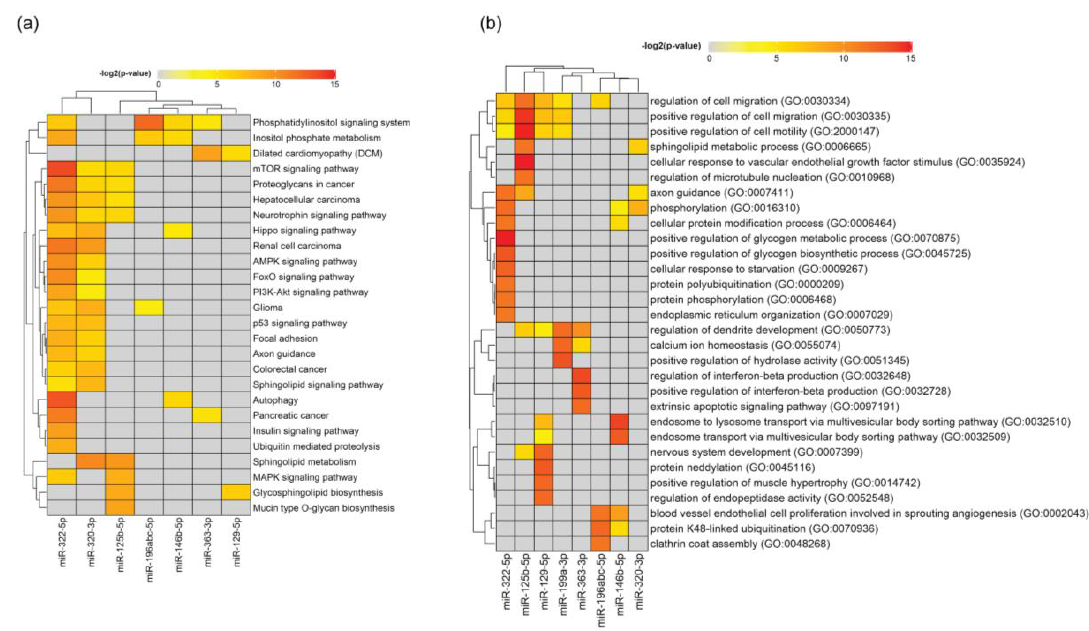
Figure 11. Pathway analysis for Ngfr − / − and Sort1 − / − Schwann cell EV cargo. ( a ) Pathway analysis for predicted targets of each individual miRNA. The 30 most significant hits from KEGG pathways are shown. The heatmap shows the level of significance—red being most significant, grey means not significant. ( b ) Pathway analysis for predicted targets of each individual miRNA. The 30 most significant hits from Gene Ontology Biological Process are shown. The heatmap shows the level of significance—red being most significant, grey means not significant.